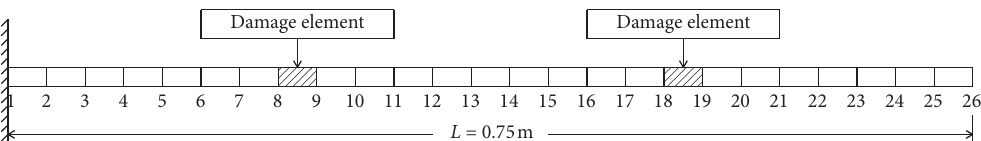
Figure 8: Schematic diagram of a cantilever beam with double damage.